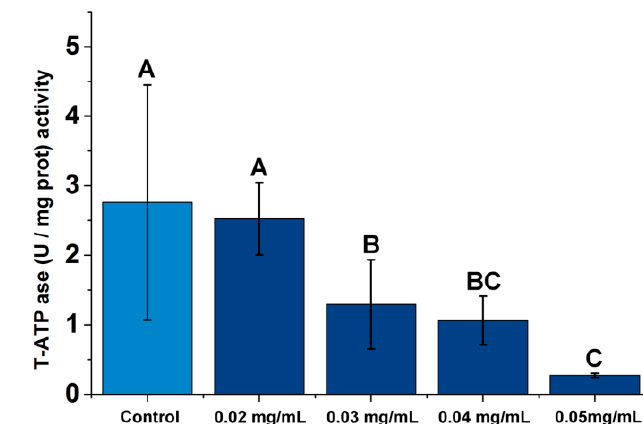
Fig. 5: Effect of Laminaria japonica extracts on ATPase activity in Cla- vibacter michiganensis subsp. michiganensis . Cells without L. ja- ponica extracts were used as the control. The results represented the means of tests (standard deviations for seven independent experi- ments). Different letters indicated significant differences ( P <0.05).